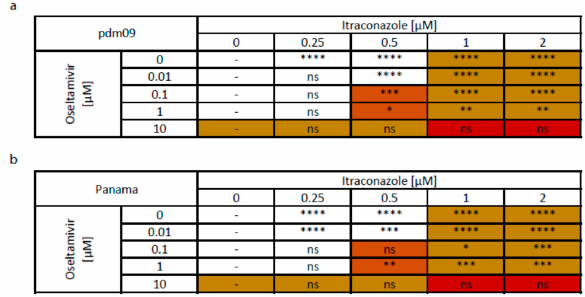
Figure 8. Overview of anti-IAV activities of combination treatments with oseltamivir and itraconazole. Polarized Calu-3 monolayers were infected with 0.1 MOI of ( a ) pdm09 or ( b ) Panama for 24 h. Oseltamivir and itraconazole were added at the indicated combinations 2 h p.i. Colored cells indicate ≥ 90% significant reduction in viral titers. Combinations with higher inhibitory activities than the respective individual drug concentrations are highlighted in yellow. Orange cells indicate inhibition ≥ 90% for combinations, with the individual drug treatment reaching inhibition ≤ 90%. Red cells indicate combinations leading to significant cytotoxicity. Asterisks indicate significant differences in antiviral activities when the reduction in viral titers found with the combined treatments was compared to the respective oseltamivir concentration.